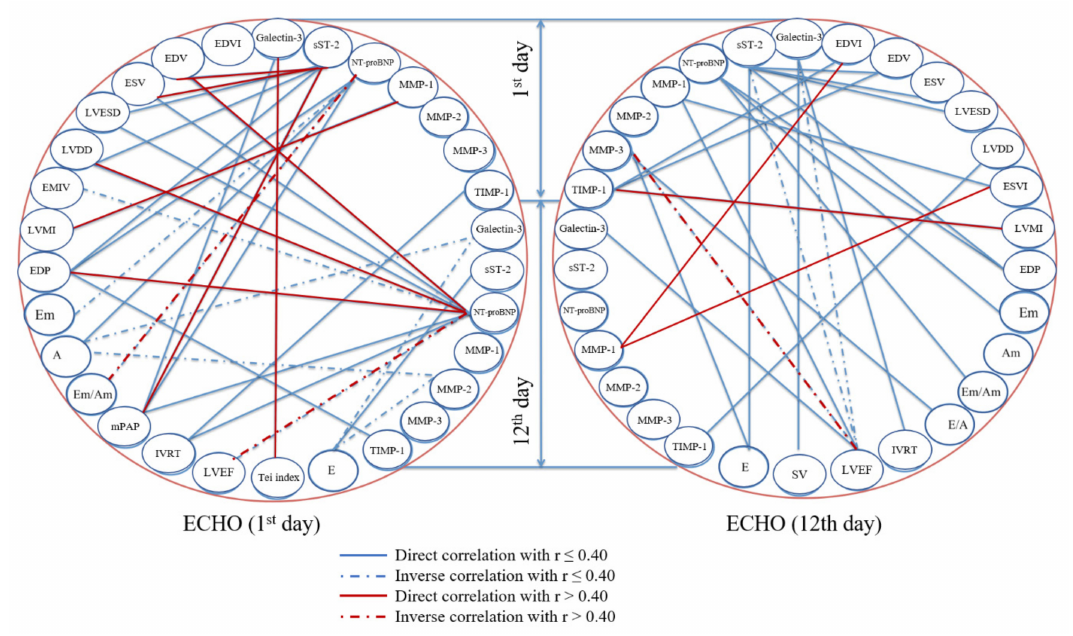
Figure 2. Correlation analysis of echocardiographic parameters and serum biomarkers in patients with ST-segment elevation myocardial infarction and preserved left ventricular ejection fraction (HFpEF, only statistically significant correlations with Spearman’s rho > 0.4–0.7 are marked red). Abbreviations